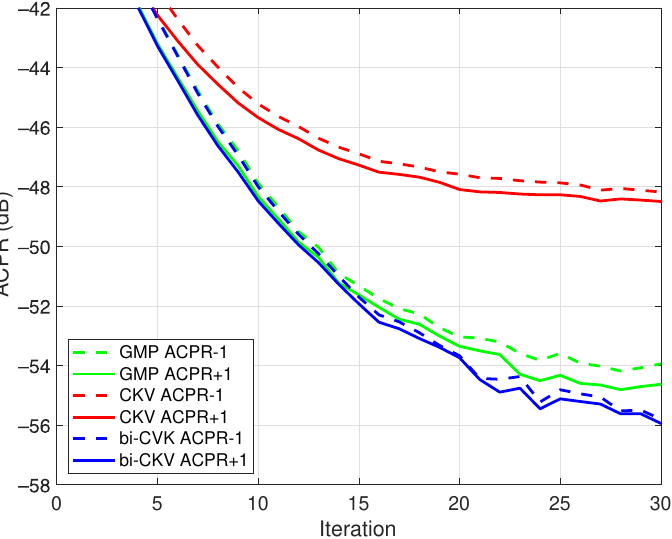
Figure 9. Evolution of the ACPR in the first two adjacent channels with the iterations in a direct learning scheme for class AB PA operated at 3.6 GHz with an average output power of 31.2 dBm. Finally, once the DPD coefficients were trained and fixed, a new validation signal was set as the input to feature the algorithm’s linearization performance by their ability to work with signals not used in the model identification stage. The normalized power spectral densities (PSDs) of the output waveform without DPD and with the benchmarked algorithms are presented in Figure 10. This figure reveals the effectiveness of the DPD exhibiting a spectral regrowth reduction in accordance to the attained performance in finding the model structure and training the DPD